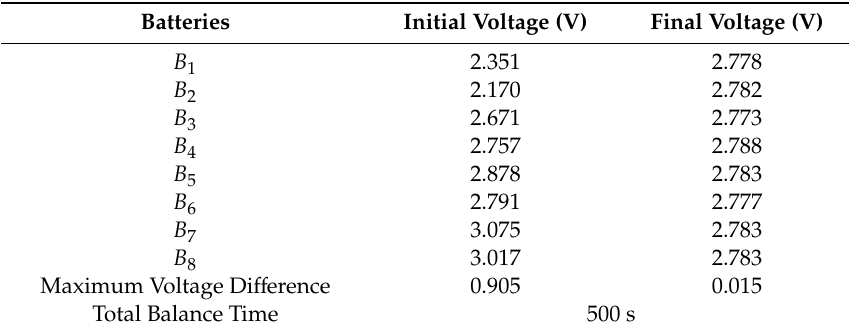
Figure 10. Battery voltage variations during offline balancing.